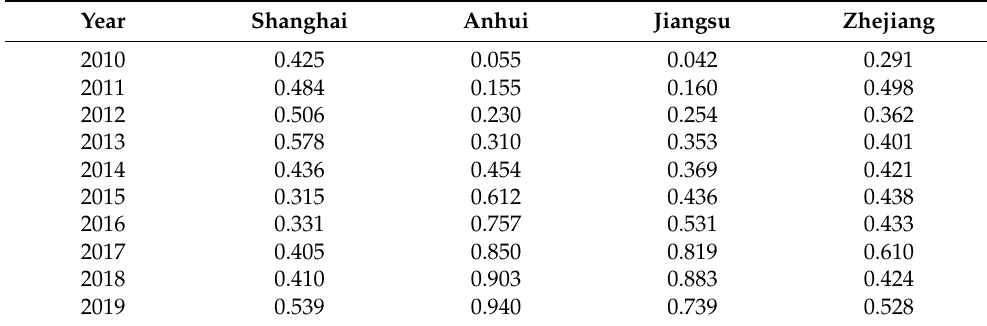
Table 4. Order degree of the carbon emission subsystems of three provinces and one city in the YRD